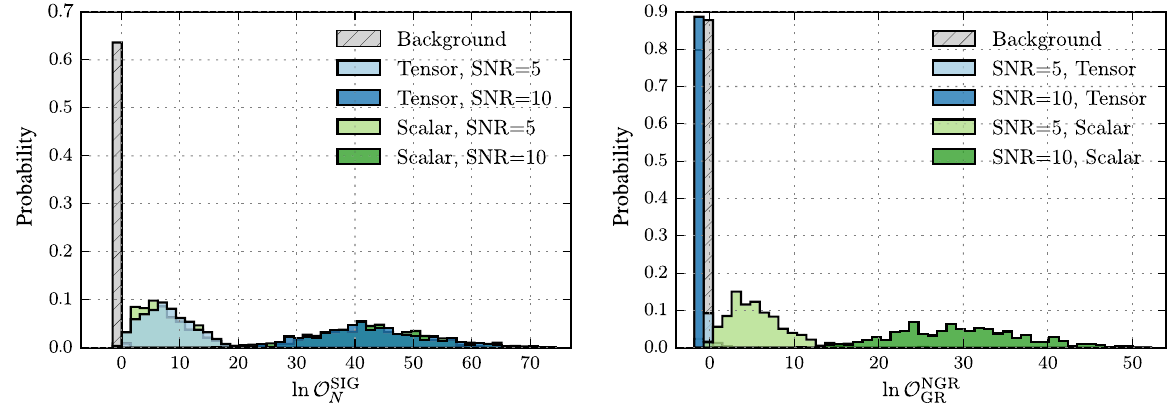
FIG. 6. Left: Distributions of odds ratios O SIG between signal and noise hypotheses for simulated observations of tensor (blue) and N scalar (green) stochastic backgrounds of slope α ¼ 2 = 3 , assuming 3 years of observation with design-sensitivity Advanced LIGO. We consider two different strengths for each polarization, corresponding to h SNR i ¼ 5 and 10. For each background strength, the tensor OPT and scalar odds ratios lie nearly on top of one another. Also shown is the background distribution of odds ratios obtained when observing ∝ SNR 2 , pure Gaussian noise (hatched gray). In the presence of a stochastic background, the recovered odds ratios grow as ln O SIG N OPT showing increasingly large preference for the signal hypothesis. Right: Odds ratios O NGR between NGR and GR hypotheses obtained for GR the same set of simulated Advanced LIGO observations. In the presence of a tensor-polarized background, we recover narrow ≈ − 1 . 4 , reflecting consistency with the GR hypothesis. A scalar background, on the other distributions of odds ratios centered at ln O NGR GR hand, yields large positive odds ratios, correctly showing a strong preference for our NGR